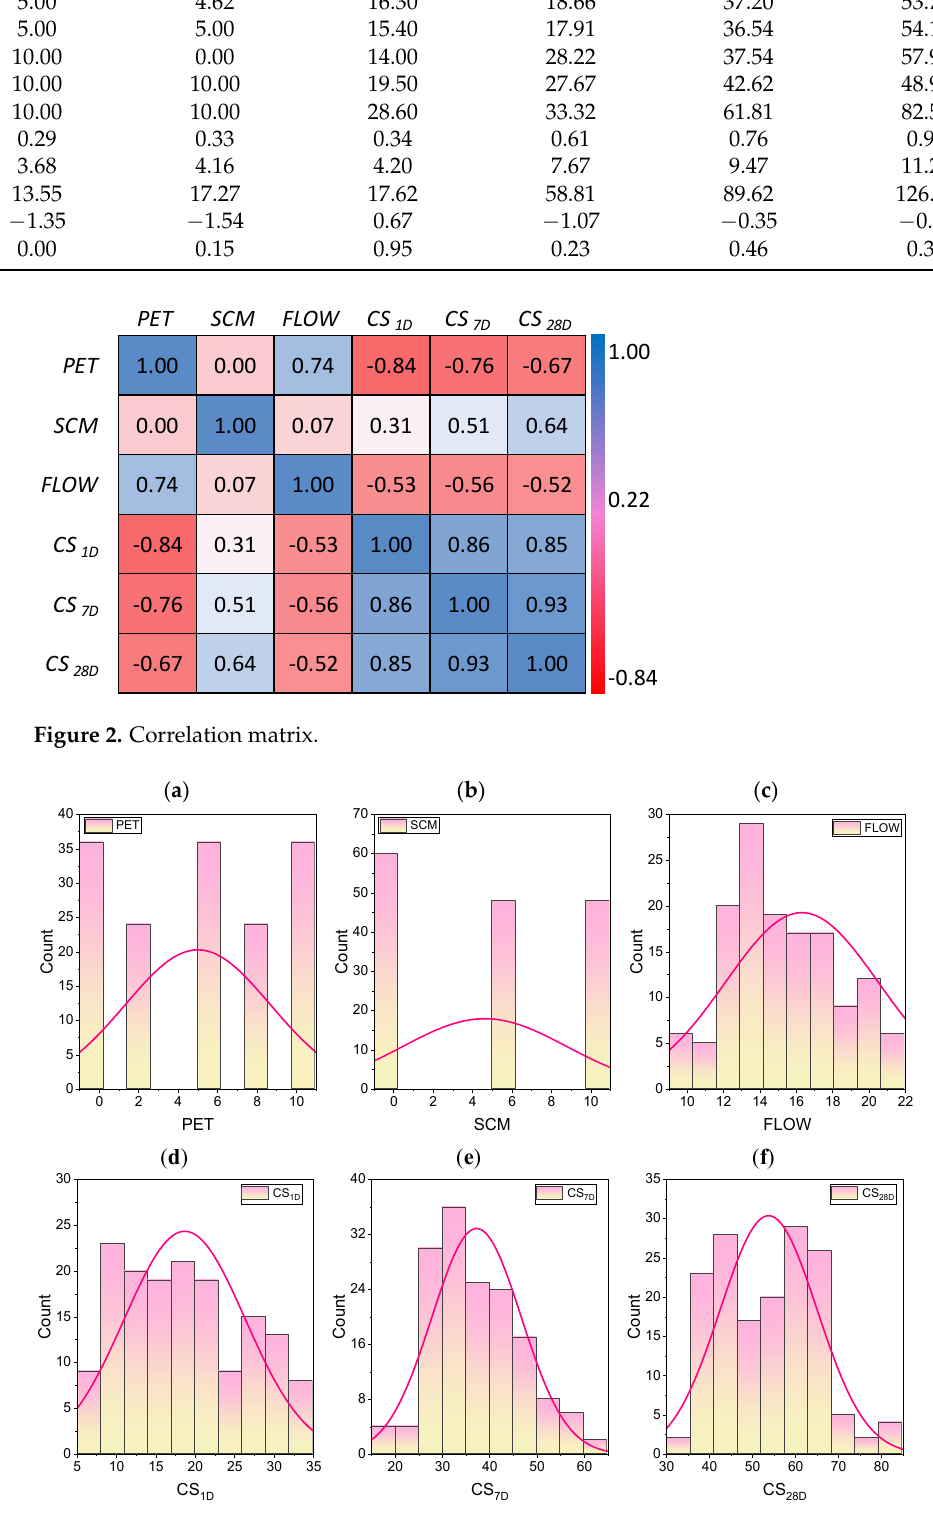
Figure 3. ( a – f ) Frequency histogram for the input and output parameters.